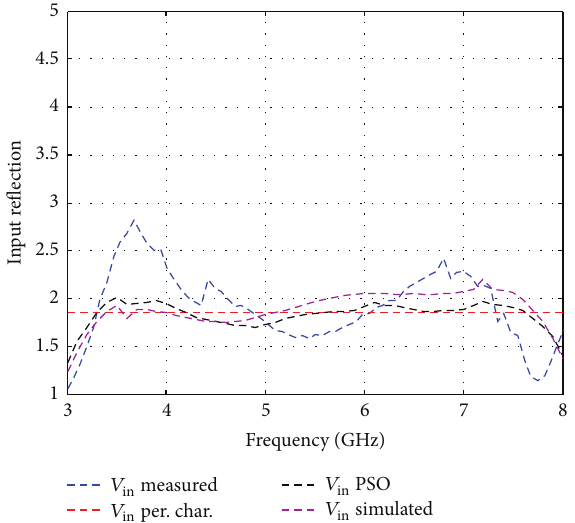
Figure 11: Comparative results for input VSWR of designed ampli-